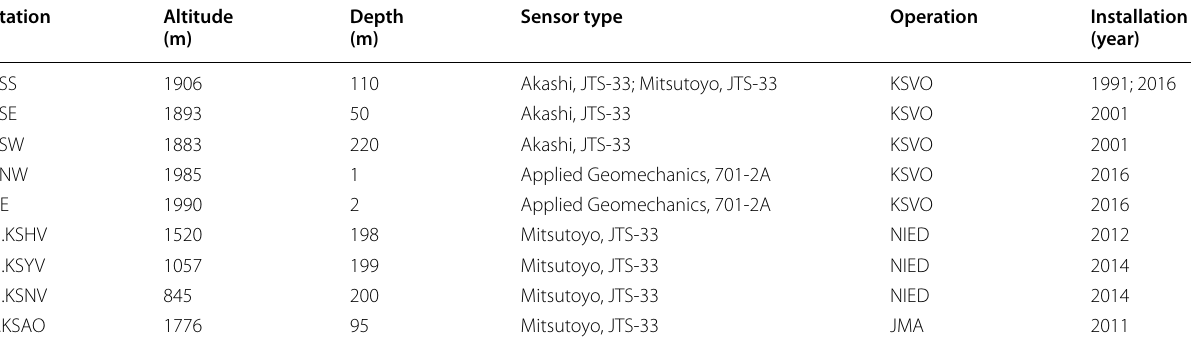
Table 1 Details of the instruments in the tiltmeter network